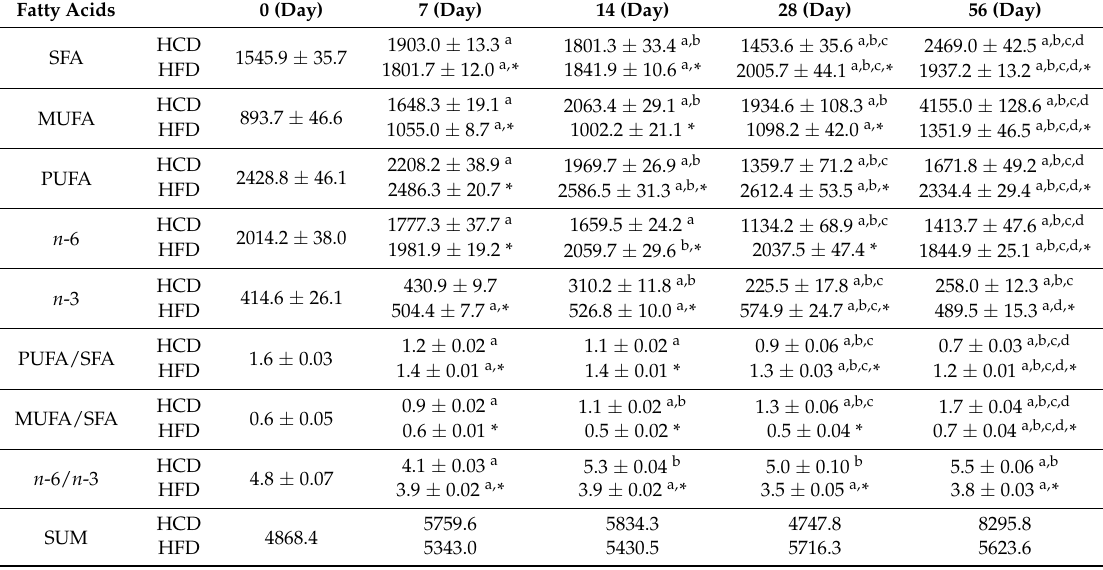
Table 3. Fatty acid family composition (mg 100/g of sample), and n -6/ n -3 fatty acid, PUFA/SFA and MUFA/SFA ratios in the liver from mice fed with high carbohydrate diet (HCD) or high fat diet (HFD) at 0 (before starting the diets) or after 7, 14, 28 or 56